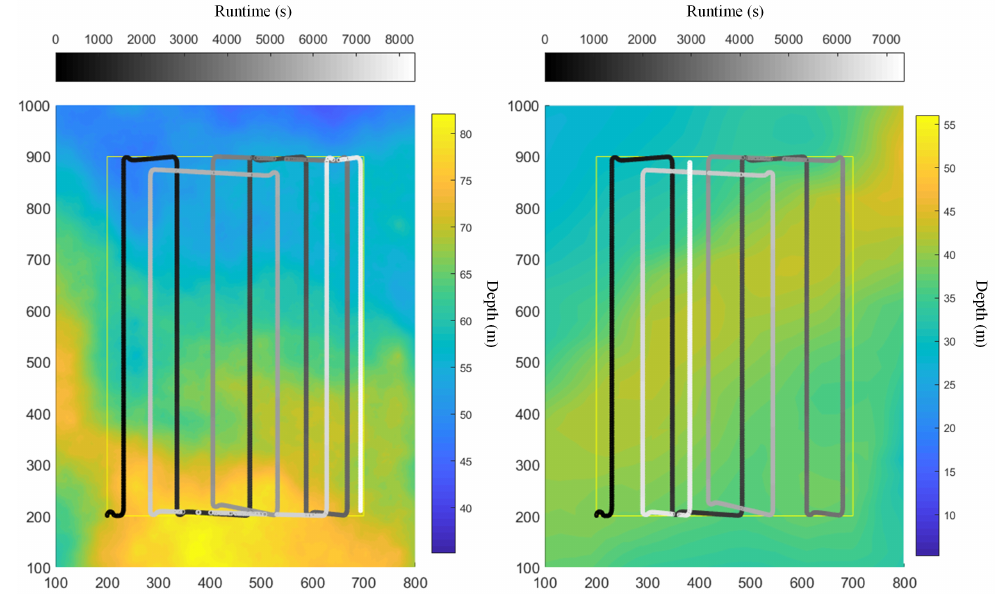
Figure 12. Path planning results of proposed method in different terrains. Both the trials applied the setup of run #2. The left terrain is generated by the same function mentioned in the previous subsection and the depth of the vehicle stays unchanged. The right terrain is generated by bathymetric data of Narragansett Bay, and the depth of the vehicle is set at 0 for this